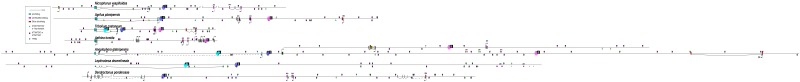
Several motif instances (3, 4, 5) show conservation within the Coleoptera.The scaffold containing the additional isolated zen paralog in Anoplophora glabripennis is shown above the zen paralogs syntenic to pb.